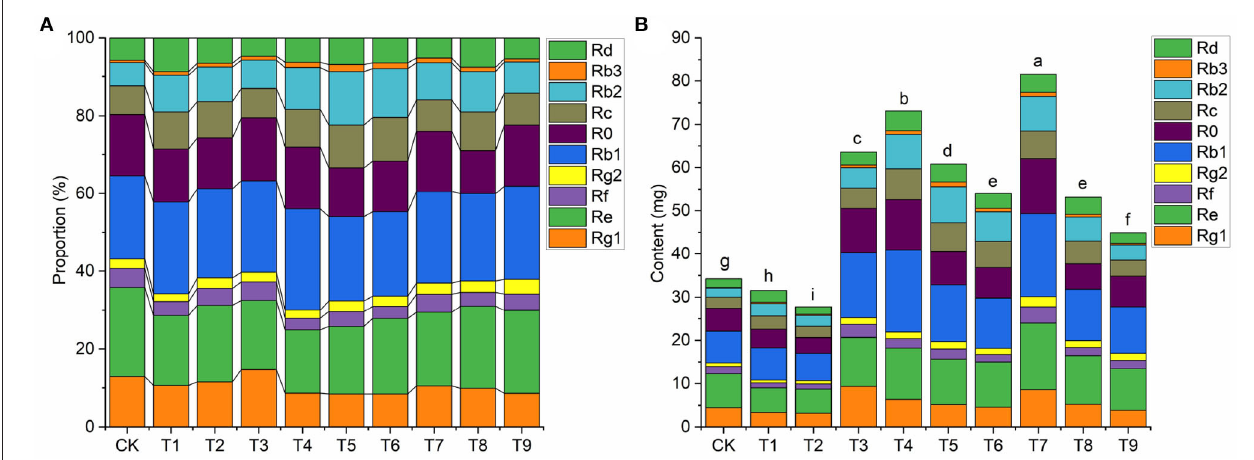
FIGURE 2 | Effects of NPK combined application on (A) proportions (%) of ginsenosides and (B) total content (mg) of ginsenosides in ginseng ( n = 3). Note: (a) Different letters indicate significant differences in total amounts at p < 0.05 according to SNK tests. (b) Composition of fertilization treatments: CK, N 0 P 0 K 0 ;